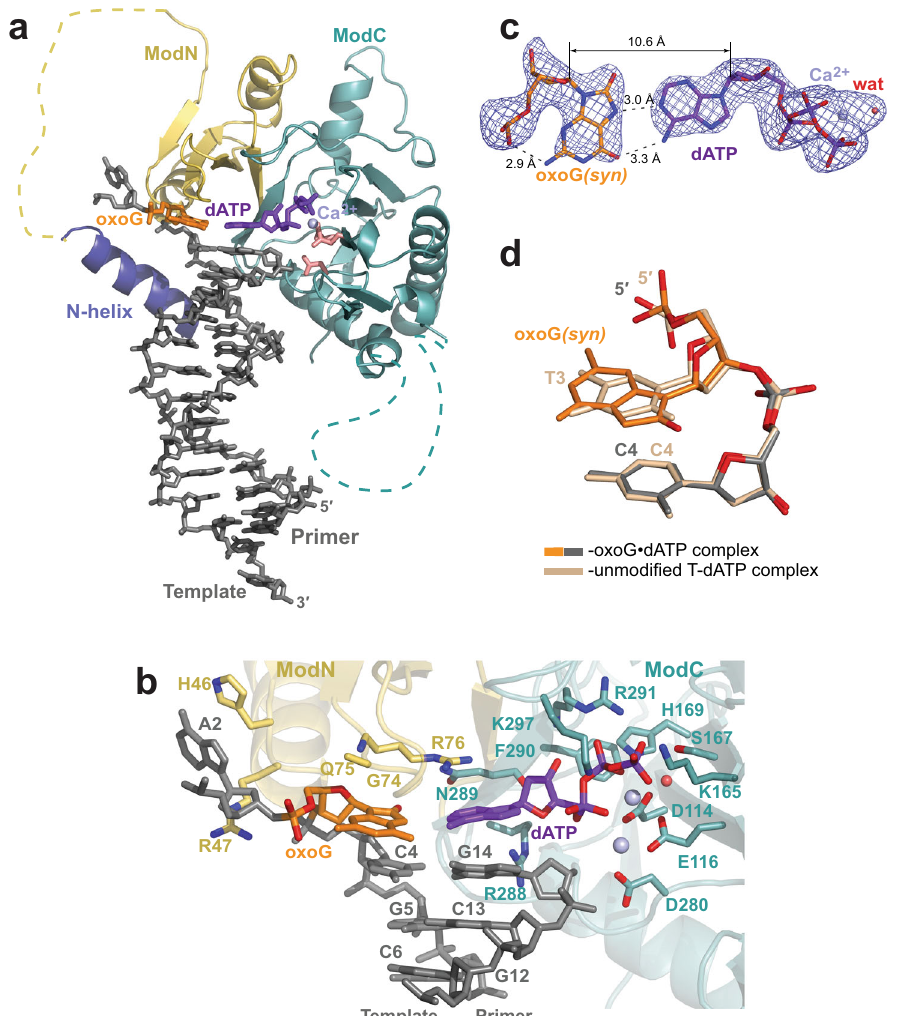
Fig. 2 Structure of human PrimPol inserting incorrect dATP opposite the oxoG template base. a The overall structure of the ternary PrimPol oxoG • dATP complex with the 2 ′ ,3 ′ -dideoxy 3 ′ -terminated primer (molecule A of the AU). The N-helix and modules ModN and ModC are shown in cartoon representation in dark blue, yellow, and cyan, respectively. The DNA is shown as gray sticks, the Ca 2 + ion ( ‘ metal B ’ ) is shown as a light blue sphere, and the water molecule coordinated by the Ca 2 + ion is shown as a small red sphere. The oxoG residue (orange) is forming a nascent base pair with the incoming dATP (purple). The unstructured regions in the ModN and ModC modules are shown as dashed yellow and cyan lines, respectively. The side chains of key catalytic active-site residues Asp114, Glu116, and Asp280 are shown as red sticks. b A close-up view of the oxoG template base and the dATP in the PrimPol active site of the 2 ′ -deoxy-3 ′ -terminated primer (intact 3 ′ -OH group)-containing complex (molecule B of the AU). There are two Ca 2 + ions (metals ‘ A ’ and ‘ B ’ ) in this complex. The key catalytic residues (Asp114, Glu116, and Asp280), the residues contacting the incoming dCTP (Lys165, Ser167, His169, Arg288, Asn289, Phe290, Arg291, and Lys297), the template oxoG base (Gly74, Gln75, and Arg76), and the rest of the template strand (Lys10, His46, and Arg47) are shown in sticks and with oxygen atoms in bright red and nitrogen atoms in blue. The side chains of Gly74 and Gln75 are disordered in this complex and, thus, not shown. c A simulated annealing Fo − Fc omit map (contoured at 2.5 σ -level at 2.40 Å resolution and colored in blue) showing the clear electron density for the entire oxoG residue in the syn conformation, its partner incoming dATP and the Ca 2 + ‘ metal B ’ ion observed in the complex with the 2 ′ ,3 ′ -dideoxy 3 ′ -terminated primer. Hydrogen bonds are indicated by black dashes. Such oxoG (syn) • dATP base pair arrangement is observed in all mentioned PrimPol oxoG • dATP complexes. d Similar phosphate backbone conformations of C2-oxoG3 (syn) -C4 (gray and orange) and unmodi fi ed C2-T3-C4 (beige) template strand segments within the PrimPol active site of their respective ternary complexes. The complexes are superimposed by ModN and ModC of PrimPol (acceptor) and the O 6 atom of the oxoG (acceptor) interacts with strand backbone conformation (Fig. 2c), the ef fi ciency of dATP the N 6 of the dATP (donor). The C1 ′ − C1 ′ distance in this oxoG incorporation opposite the oxoG is markedly reduced compared (syn) (cid:129) dATP base pair is 10.6 Å, allowing for a perfect fi t into the to that of dCTP, namely 5.7-fold less in the presence of Mg 2 + and active site of PrimPol. There is also a stabilizing intramolecular 1.8-fold less in the presence of Mn 2 + 22 . From the structure, this bond within the oxoG (syn) residue, between the N 2 atom of the reduction in incorporation of dATP versus dCTP is not caused by any structural interference per se; instead, it may re fl ect the base and the oxygen atom of its phosphate group. reduced thermodynamic stability of an oxoG (cid:129) dATP Hoogsteen While the oxoG (syn) residue fi ts the PrimPol active site base-pair compared to an oxoG-dCTP WC base-pair 43 . without altering any active site residues (Fig. 2b) or template